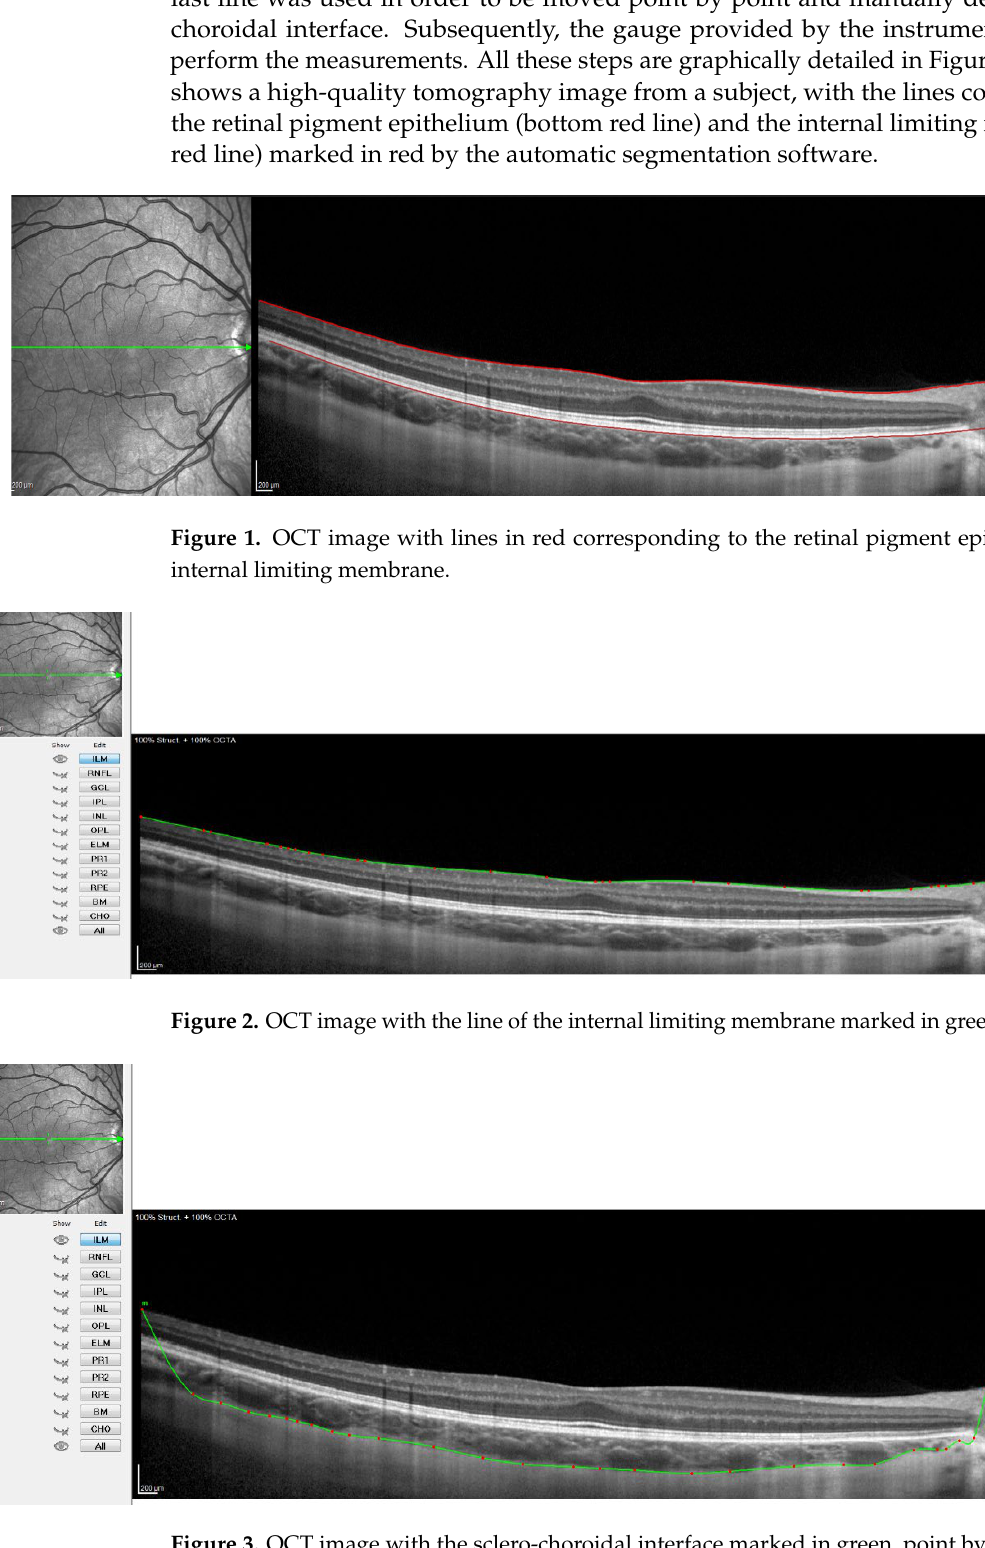
Figure 3. OCT image with the sclero-choroidal interface marked in green, point by point.